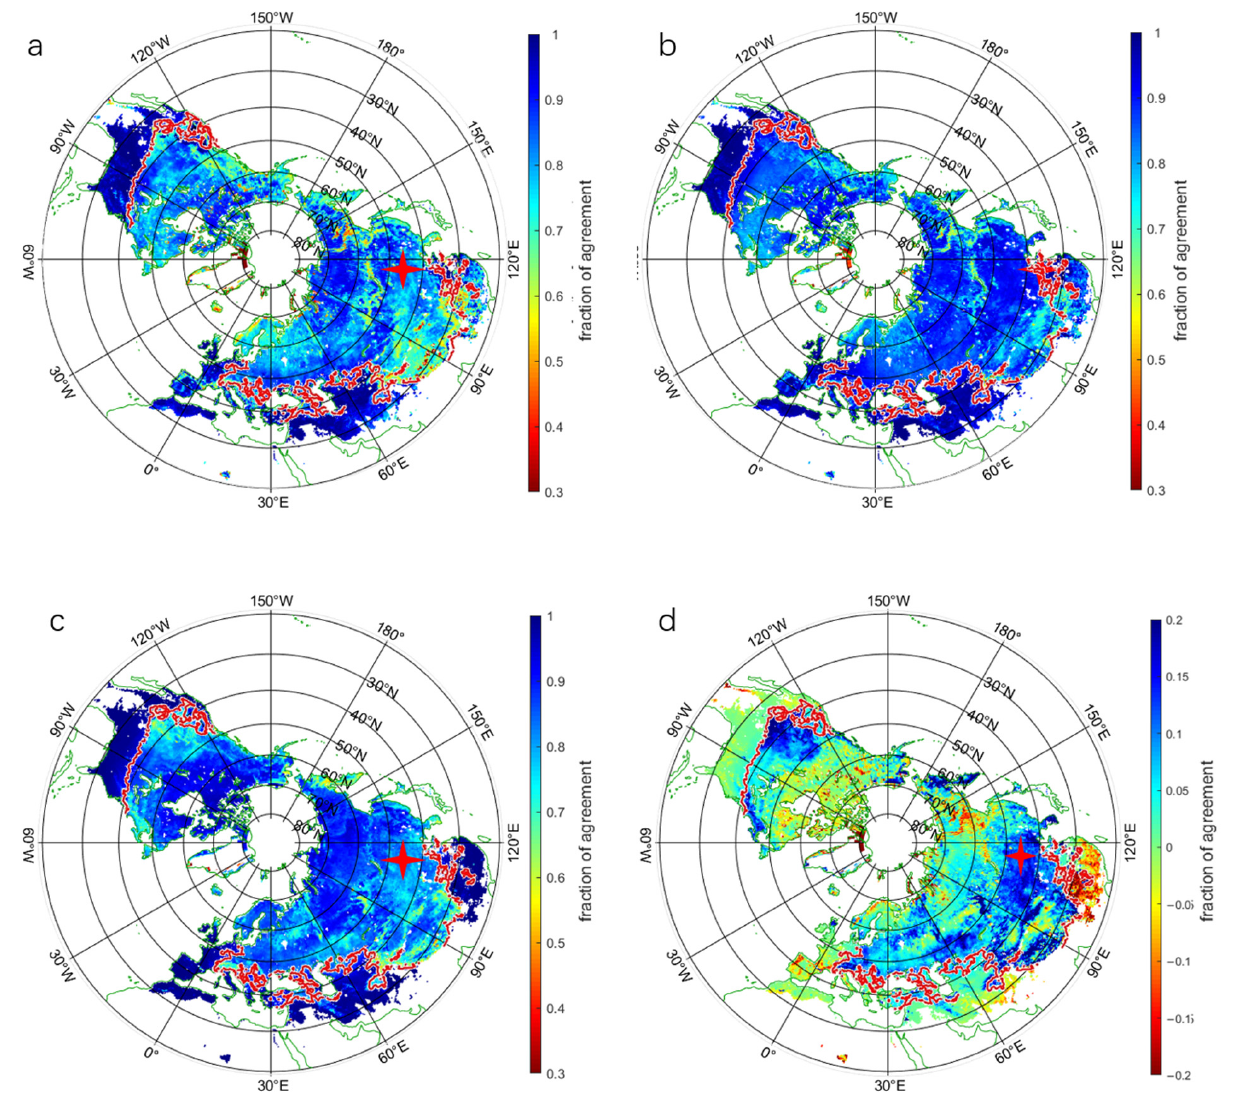
Figure 9. The spatial pattern of the fraction of agreement in the northern hemisphere between ( a ) the new method and SMAP L3 FT state products; ( b ) the new method and ERA-land-assessment data; ( c ) the SMAP L3 FT state products and ERA-land-assessment data; and ( d ) the difference by b minus c. The red cross marks the location of Xilinhot, and the red line is the boundary between SMAP’s NPR threshold method and the single channel algorithm.